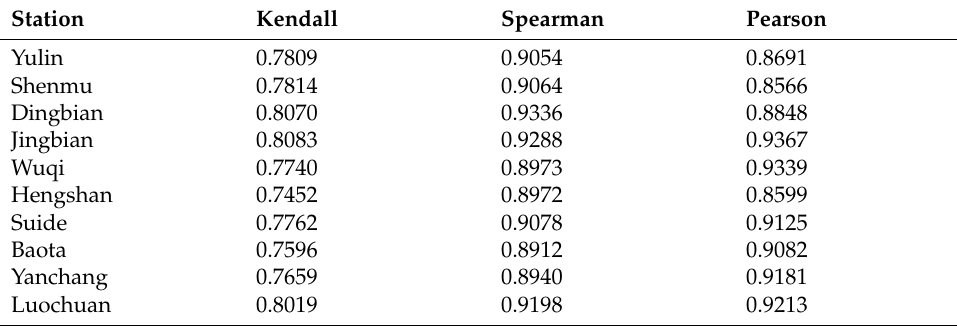
Figure 3. The frequency distribution of drought events of different grades in Northern Shaanxi during 1960–2019 ( a ) light drought; ( b ) moderate drought; ( c ) severe drought; ( d ) extreme drought. Table 3. Correlation coefficient of drought variables at each